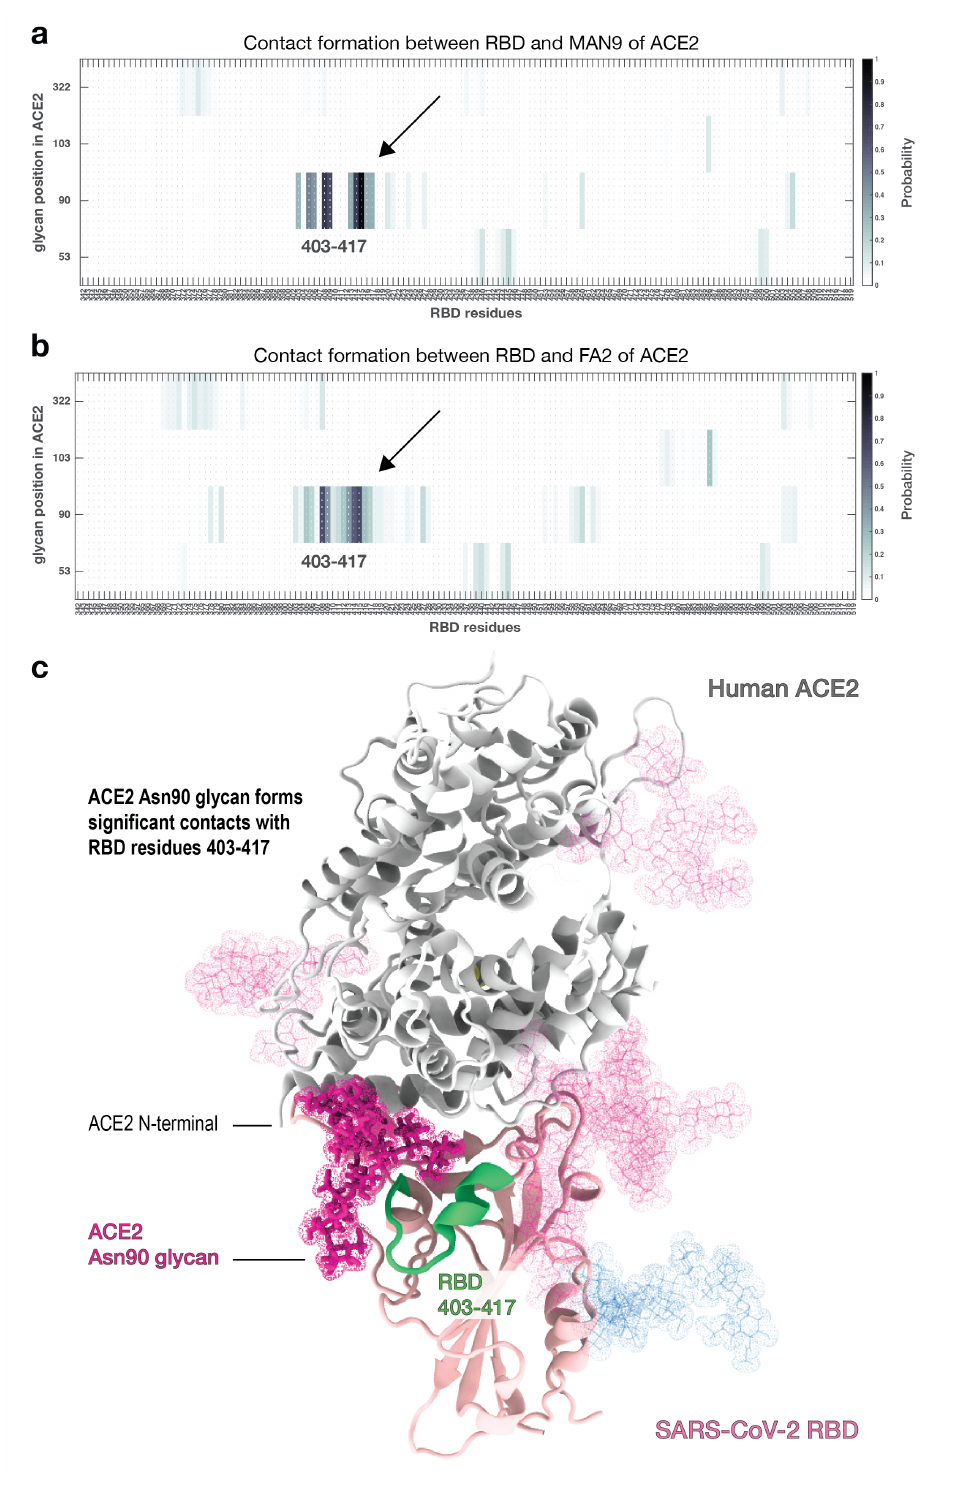
Figure 4. Only the glycan on Asn90 of ACE2 forms significant contacts with RBD. ( a ) Probability of contact formation between RBD and MAN9 glycans of ACE2. ( b ) Contact probability between RBD and FA2 glycans of ACE2. Both ( a , b ) show that only the contacts involving Asn90 glycan occur with higher probabilities (see region indicated by arrow). RBD residues that form these protein-glycan interactions are roughly between 403–417. This RBD region does not form contacts with ACE2 in the non- glycan or glycan-included simulations (cf. Figure2a–c). This suggests that the glycans do not compete with protein-protein interactions at the RBD-ACE2 interface. ( c ) Structural description of the ACE2 Asn90 glycan (magenta) and RDB residues 403–417 (green), forming glycan-protein